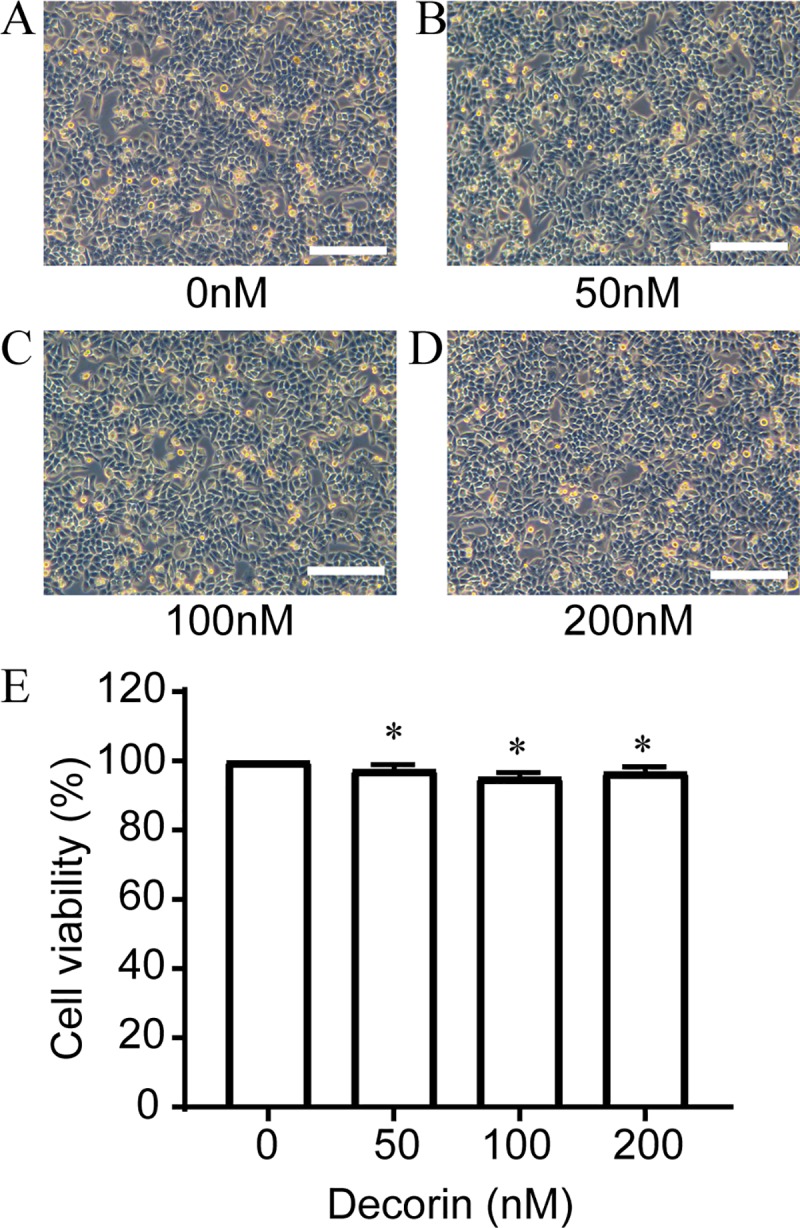
Cell viability of HLEB3 cells at different concentration of decorin as tested by CCK-8 assay.(A-D) Cell morphology at different concentrations of decorin. No obvious morphological change was found at different concentrations of decorin under the light microscope. (E) No significant difference in cell viability was found among the different concentration groups tested by CCK-8 assay (*P > 0.05 vs 0nM group). Bars are means ± SEM.